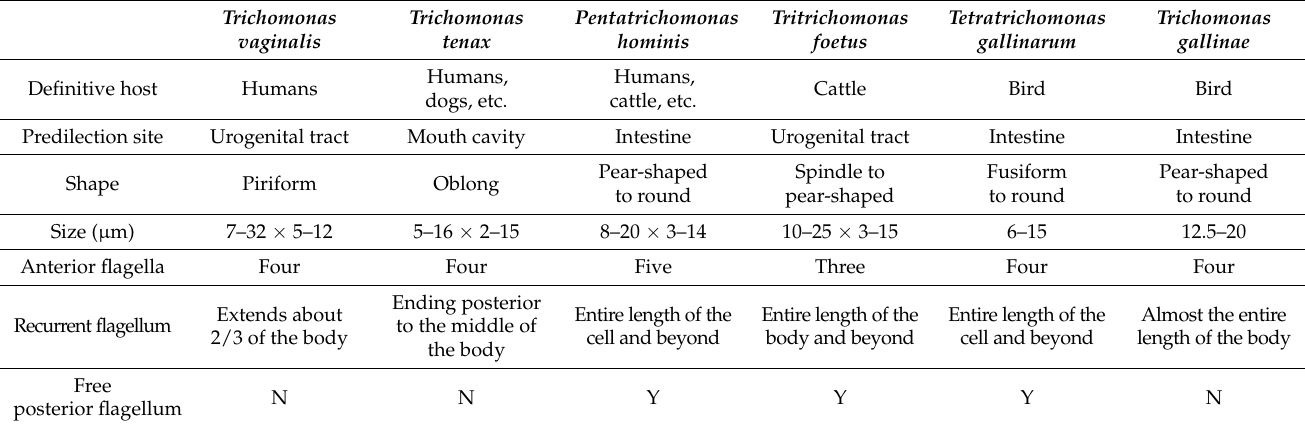
Table 2. Morphological characteristics of trichomonad protozoa found in human infections a